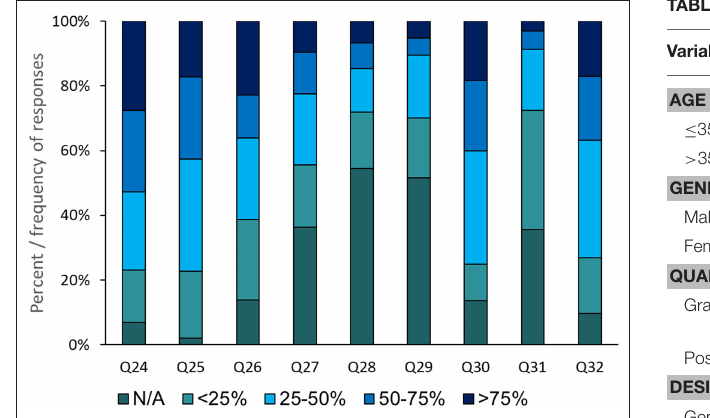
The mean awareness of respondents (section 3) was 12.65